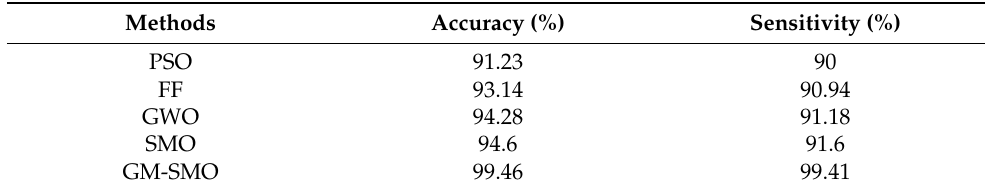
Table 2. Feature selection techniques’ comparison in scene classification on three datasets.